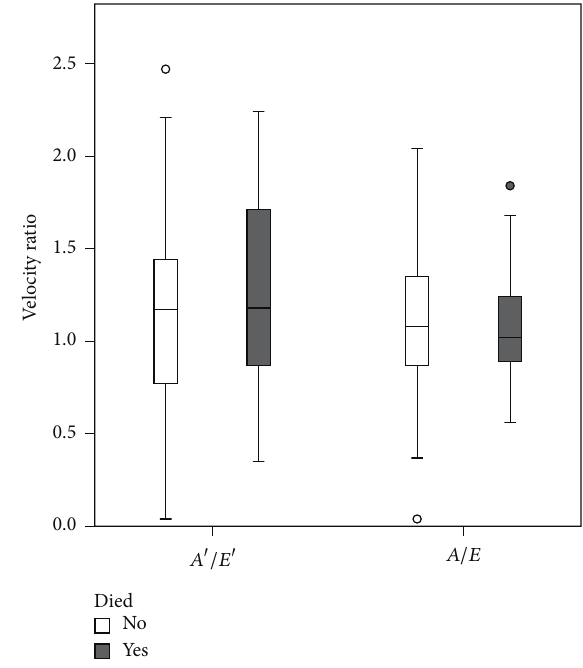
Figure 2: The box plot shows that there is no evidence for a difference in the distribution of the two echocardiographic variables of diastolic dysfunction between survivors and nonsurvivors.